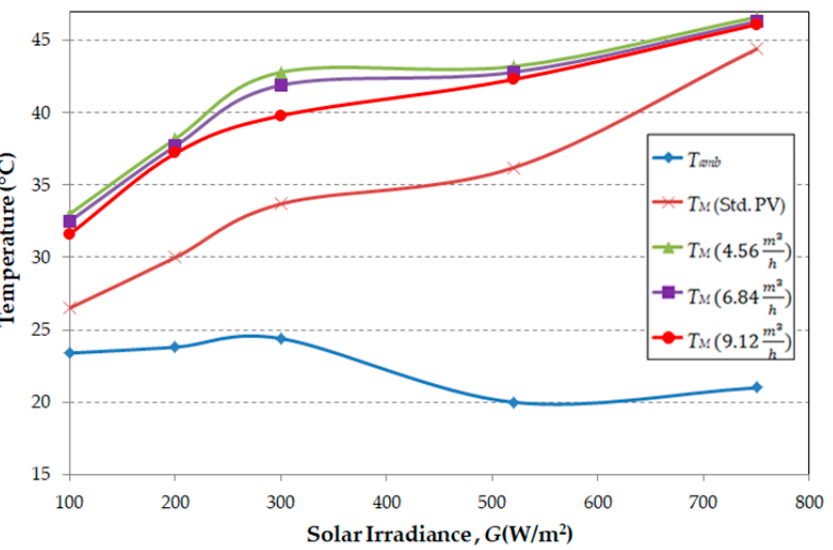
Figure 6. Influence of solar irradiance ( G ) on the PV module temperature ( T M ) for all tested cases (the ambient temperatures T amb during the tests are also presented).